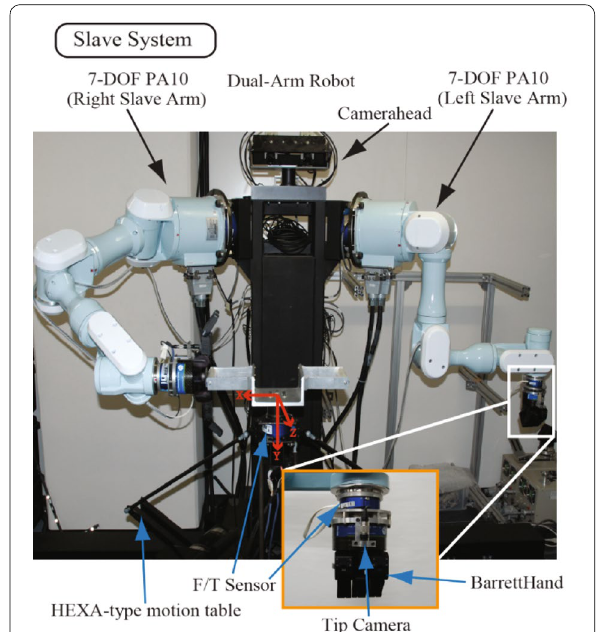
Fig. 3 Overview of the slave